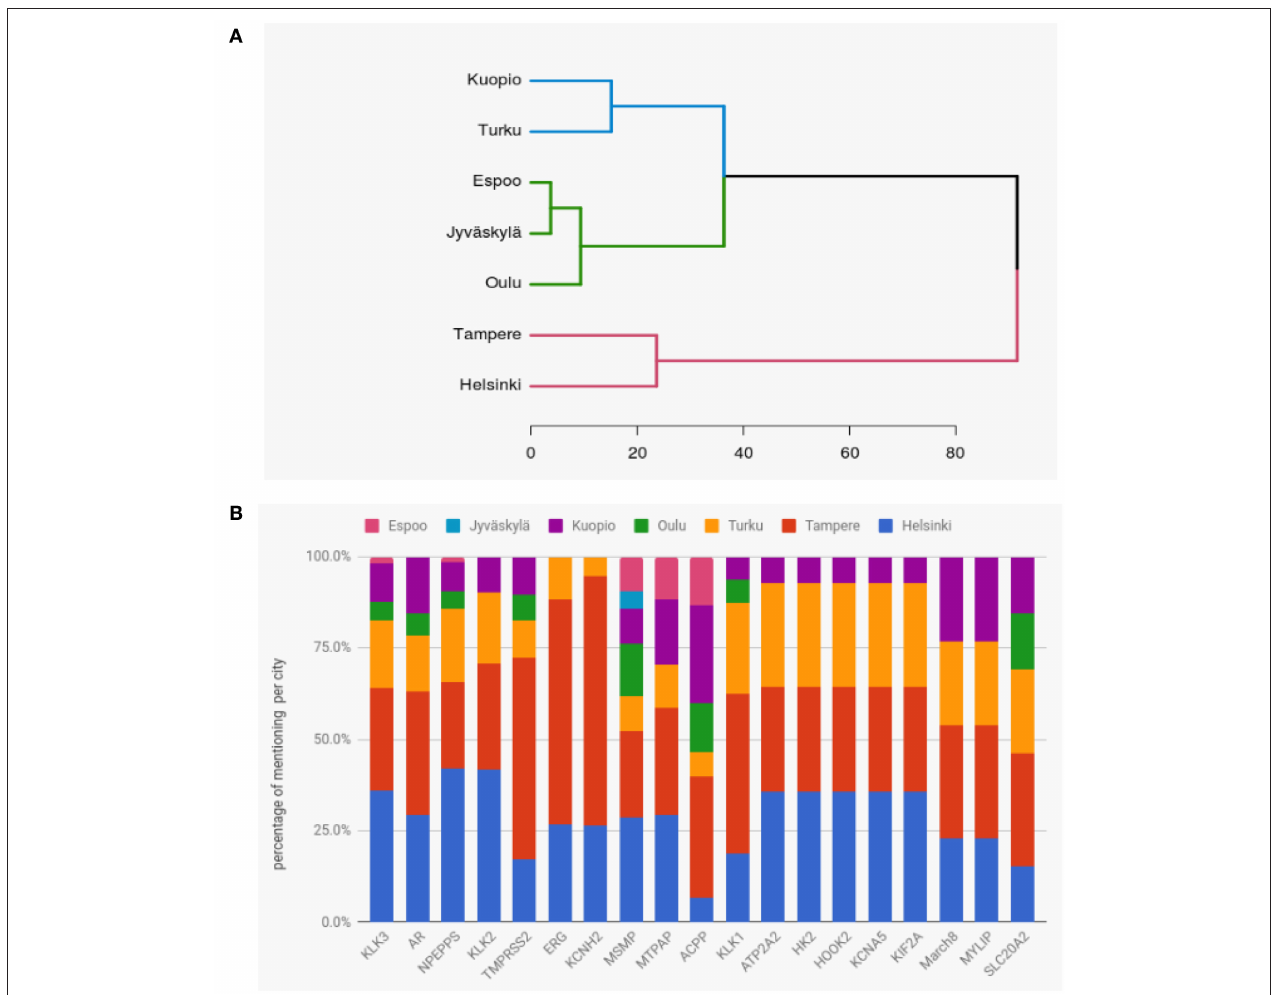
FIGURE 11 | (A) Hierarchical clustering of cities in Finland showing their similarity of research interests in prostate cancer related genes. The results are based on the top 19 genes. (B) Proportions of mentioning of the top 19 genes in publications by the cities of